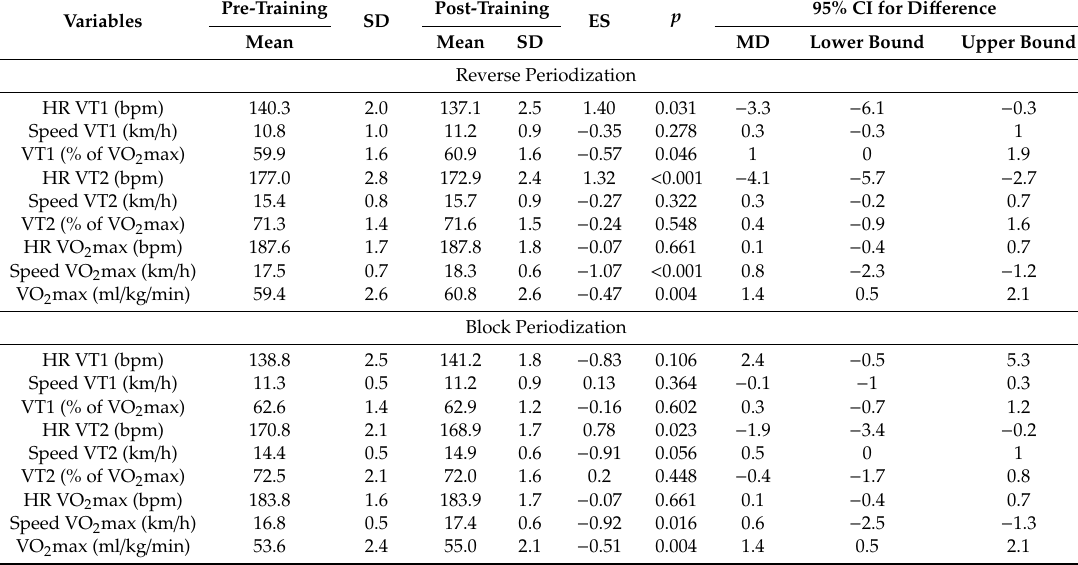
Table 3. Treadmill running test results in both groups.